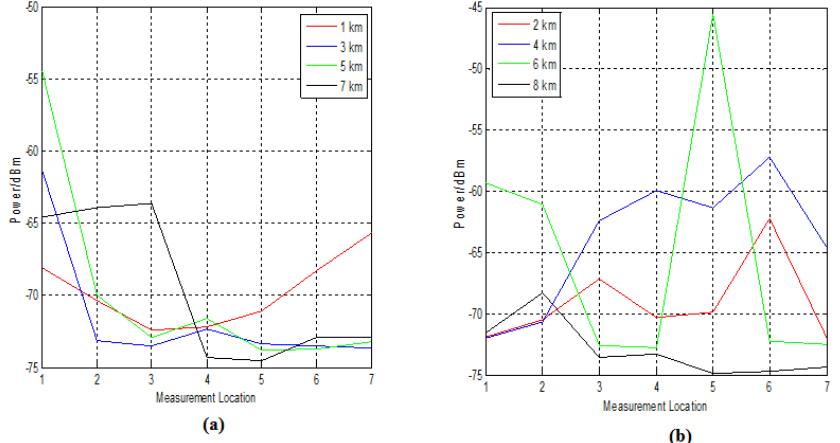
Figure 9. Radiofrequency intensities at various measurement locations of different distances from the transmitter for the 542 MHz frequency taken from the sub 700 MHz frequency band. The distances are odd for (a) and even for